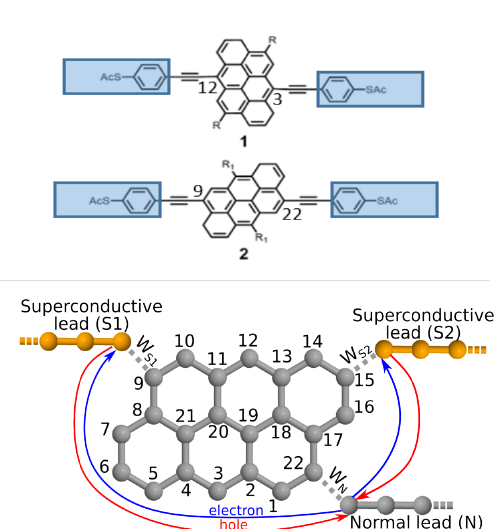
Figure 1. The top and middle panels show molecules 1 and 2, with connectivities 12,3 and 9,22 to the anthanthrene molecular core. The lower panel shows an Andreev interferometer consisting of an anthanthrene molecule, two superconducting leads and one normal lead. The “sites” of the associated tight-binding model represent p z orbitals of the anthanthrene molecule and are labelled according to the figure. The coupling of the molecule to the normal (superconducting) lead is denoted by W N ( W S ), for details see the text. The superconducting leads are characterized by a superconducting order parameter ∆ e i φ 1 and ∆ e i φ 2 . The transport processes responsible for the conventional interference effect are indicated by solid lines for the electron-like (blue) and hole-like (red)